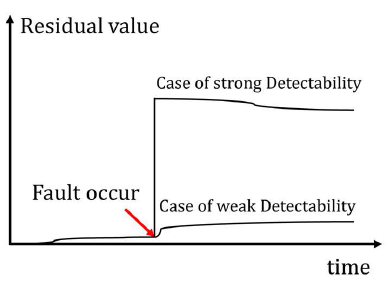
Figure 3. Fault detectability (strong/weak).